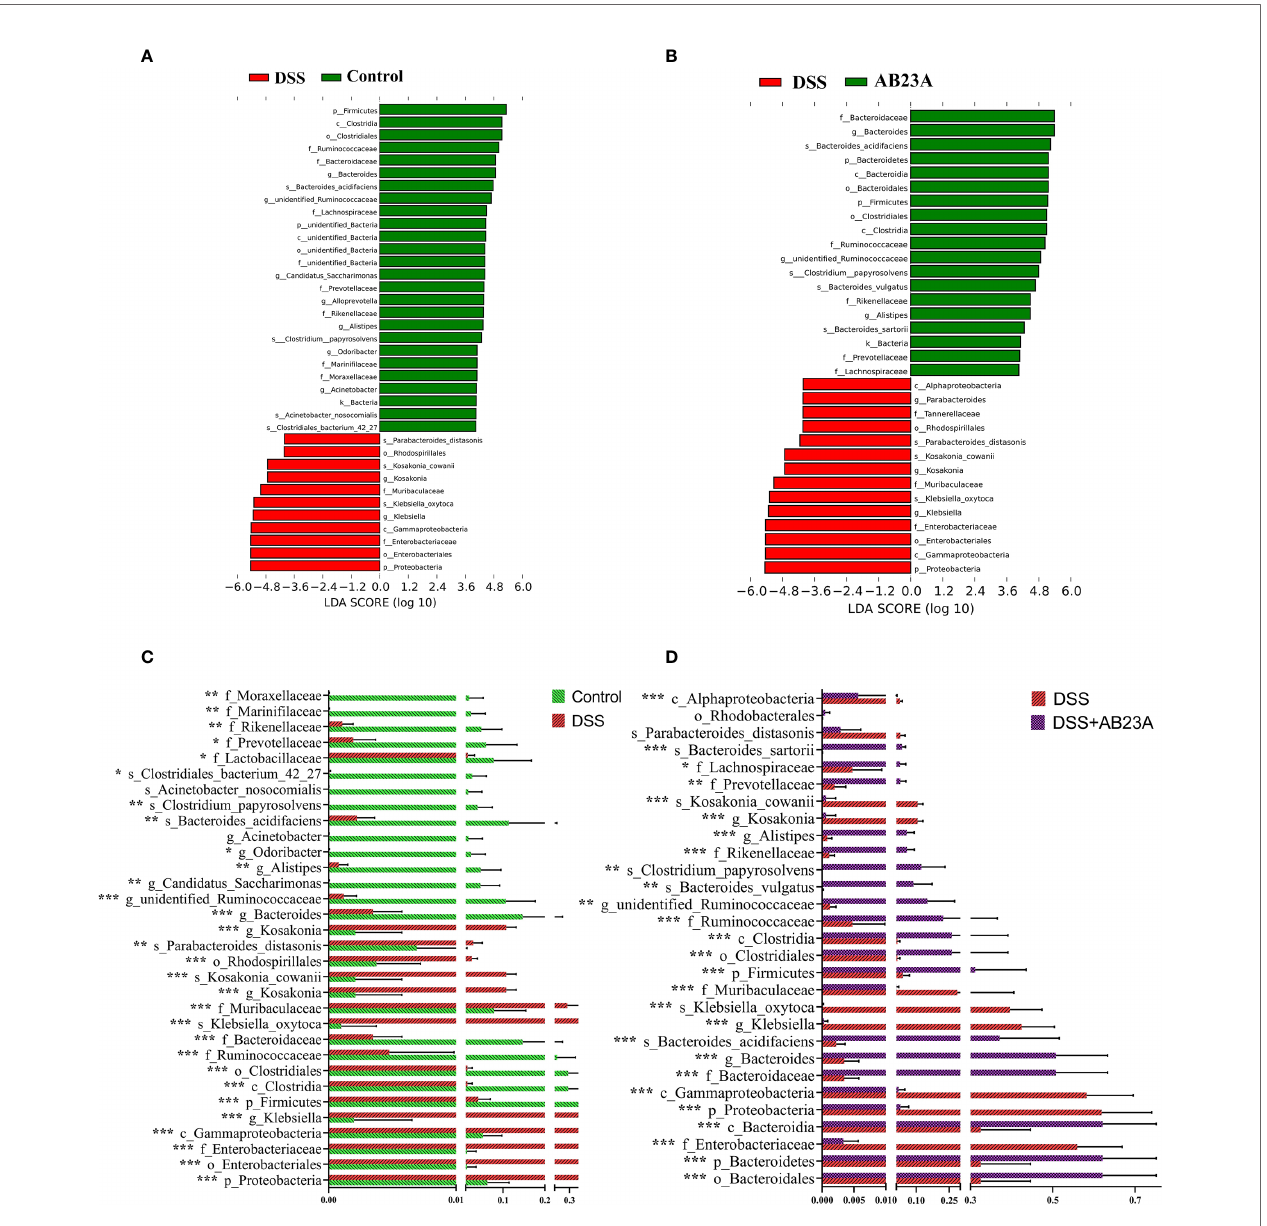
FIGURE 5 | Species distributions of gut microbiota in each group. (A) LDA value-based distribution histogram between the control group and the DSS group (LDA > 4.0). (B) LDA value-based distribution histogram between the DSS group and the AB23A group (LDA > 4.0). (C) Comparison of relative abundance of different bacteria between the control group and the DSS group. (D) Comparison of relative abundance of different bacteria between the DSS group and the AB23A group. Differences were analyzed by Unpaired T-test (*P < 0.05, **P < 0.01, ***P < 0.001, n =